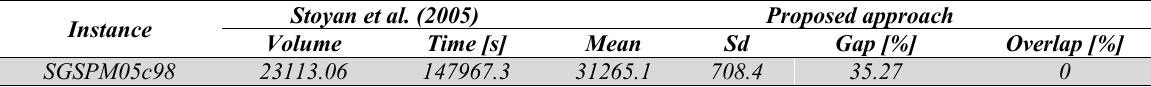
Results of the instance SGSPM05 c98